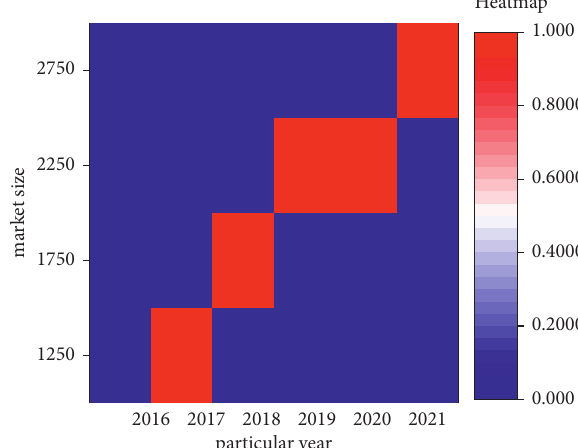
Figure 5: Trend of medical industry